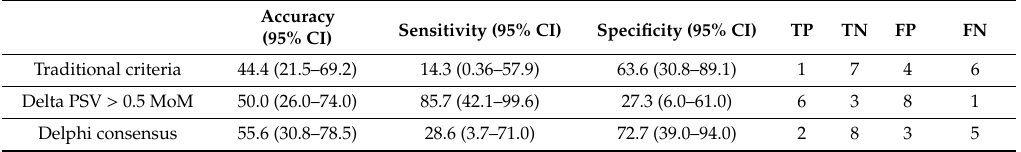
Table 3. Diagnostic accuracy of traditional, delta PSV > 0.5 MoM, and Delphi consensus criteria, according to postnatal hemoglobin *.